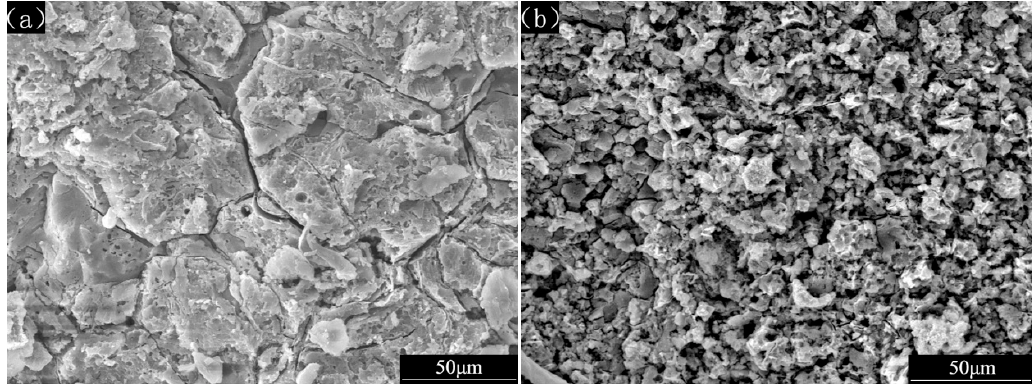
Figure 3. The SEM (secondary electron) micrograph of ( a ) LA143 alloys and ( b ) YAl 2p /LA143 composites’ surface after 72 h immersion in 3.5 wt.% NaCl solution.